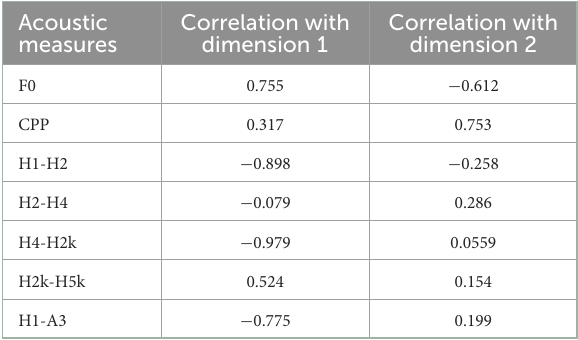
TABLE 6 Correlation coefficient between acoustic parameters and MDS coordinates (three decimal places). Acoustic